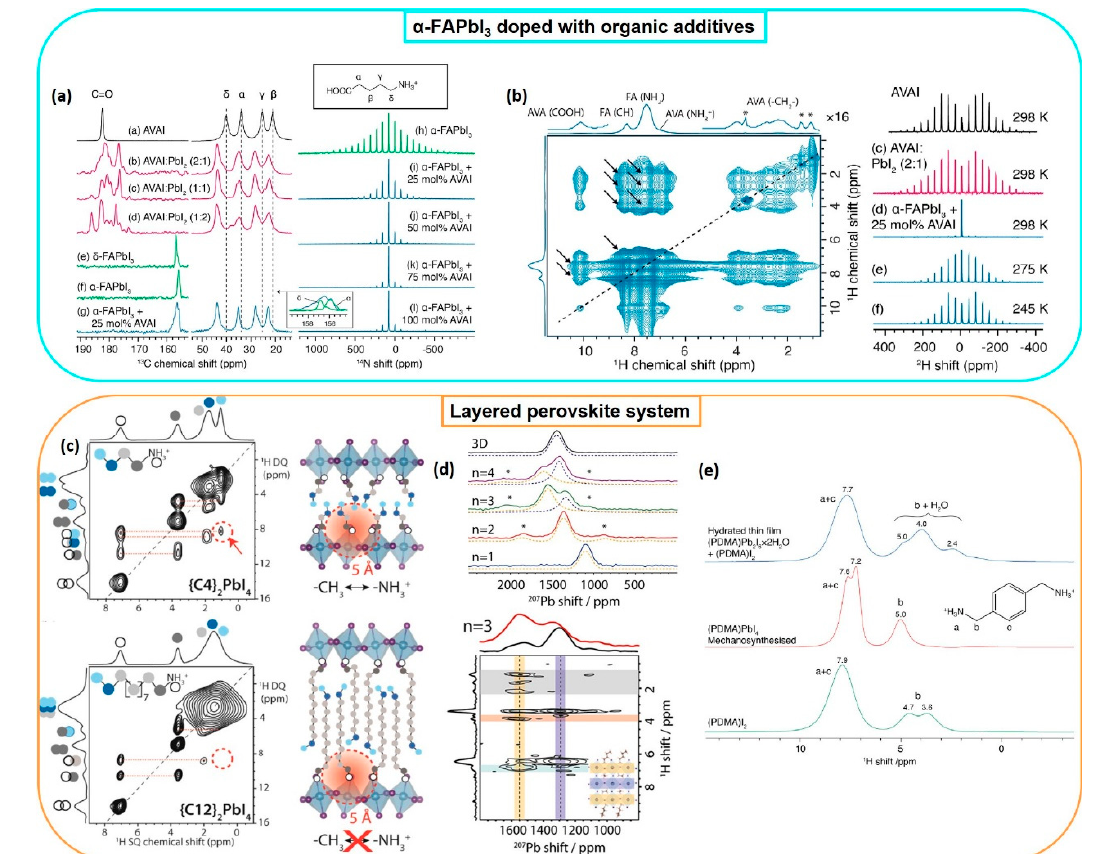
Figure 2. ( a ) Left: 1 H − 13 C CP MAS spectra of AVAI and AVAI:PbI 2 at different molar ratios; right: 14 N MAS NMR spectra of α -FAPbI 3 , and α -FAPbI 3 doped with different amounts of AVAI. ( b ) Left: 1 H- − 1 H spin diffusion measurement, where the arrows indicate the intermolecular interactions between CH and NH 2 of FA and AVA protons; right: 2 H MAS spectra of neat AVAI, (c) AVAI:PbI 2 and α -FAPbI 3 + 25 mol% AVAI at (d) 298 K, (e) 275 K and (f) 245 K. Reprinted with permission from ref. [73]. Copyright 2019 American Chemical Society. ( c ) Two-dimensional 1 H DQ − SQ NMR correlation spectra of (C4) 2 PbI 4 and (C12) 2 PbI 4 . Reprinted with permission from ref. [78]. Copyright 2021 American Chemical Society. ( d ) Top: 207 Pb Hahn-echo spectra of 2D BA 2 MA n − 1 Pb n I 3n+1 and 3D MAPbI 3 perovskite; bottom: 1 H-detected 207 Pb → 1 H spectra for BA 2 MA n − 1 Pb n I 3n+1 (n = 3). Spinning sidebands are marked by asterisks (*). Reprinted with permission from ref.